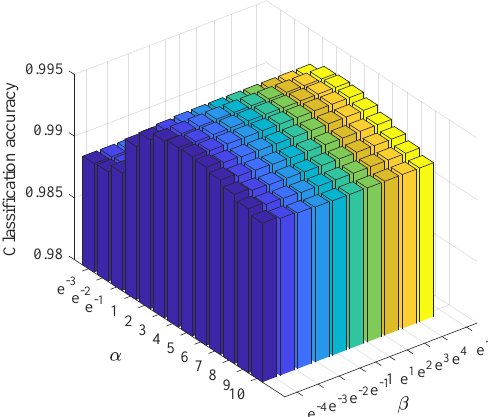
Figure 5. Classification accuracy vs different parameters: classification accuracy curve vs number of regularized parameters α and β .